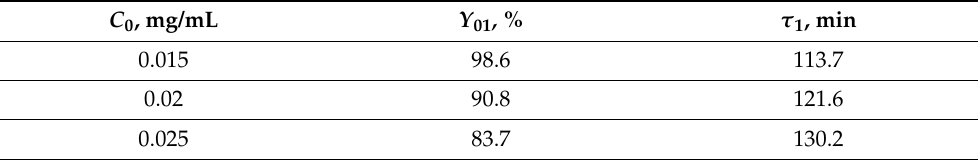
Table 1. The values of pre-exponential factors Y 01 and relaxation times τ 1 for natural water.